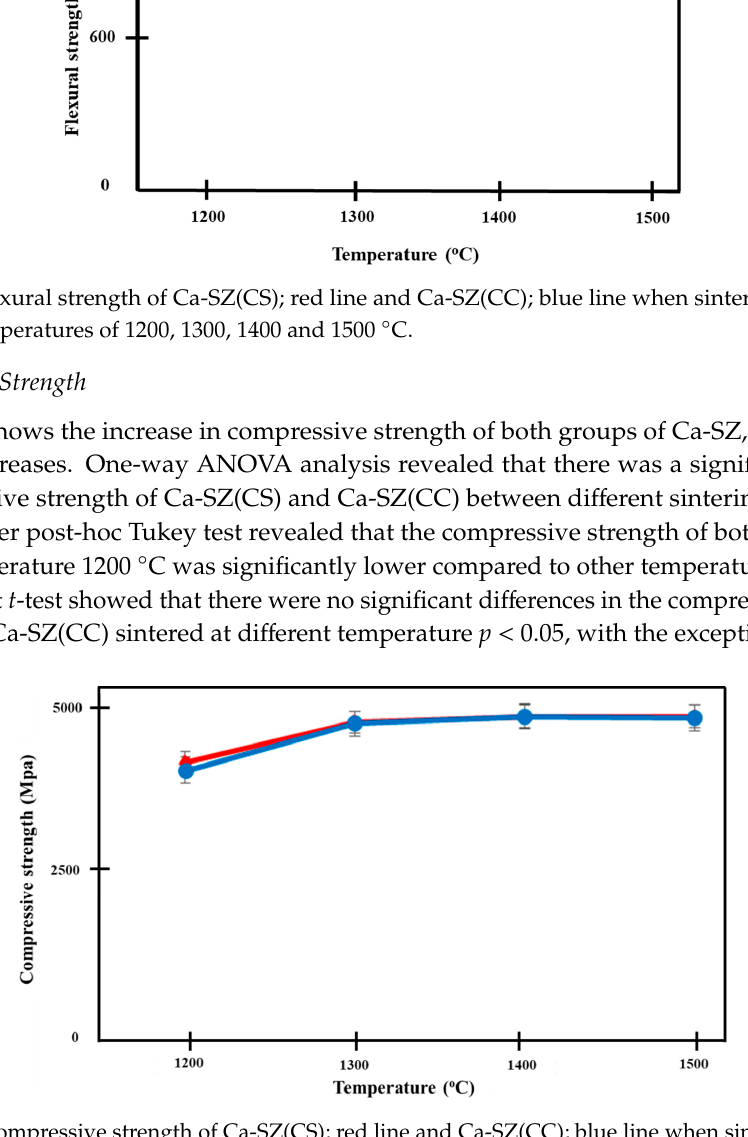
Figure 8. Density of Ca-SZ(CS); red line and Ca-SZ(CC); blue line when sintered for 2 h at different temperatures of 1200, 1300, 1400 and 1500 ° C.